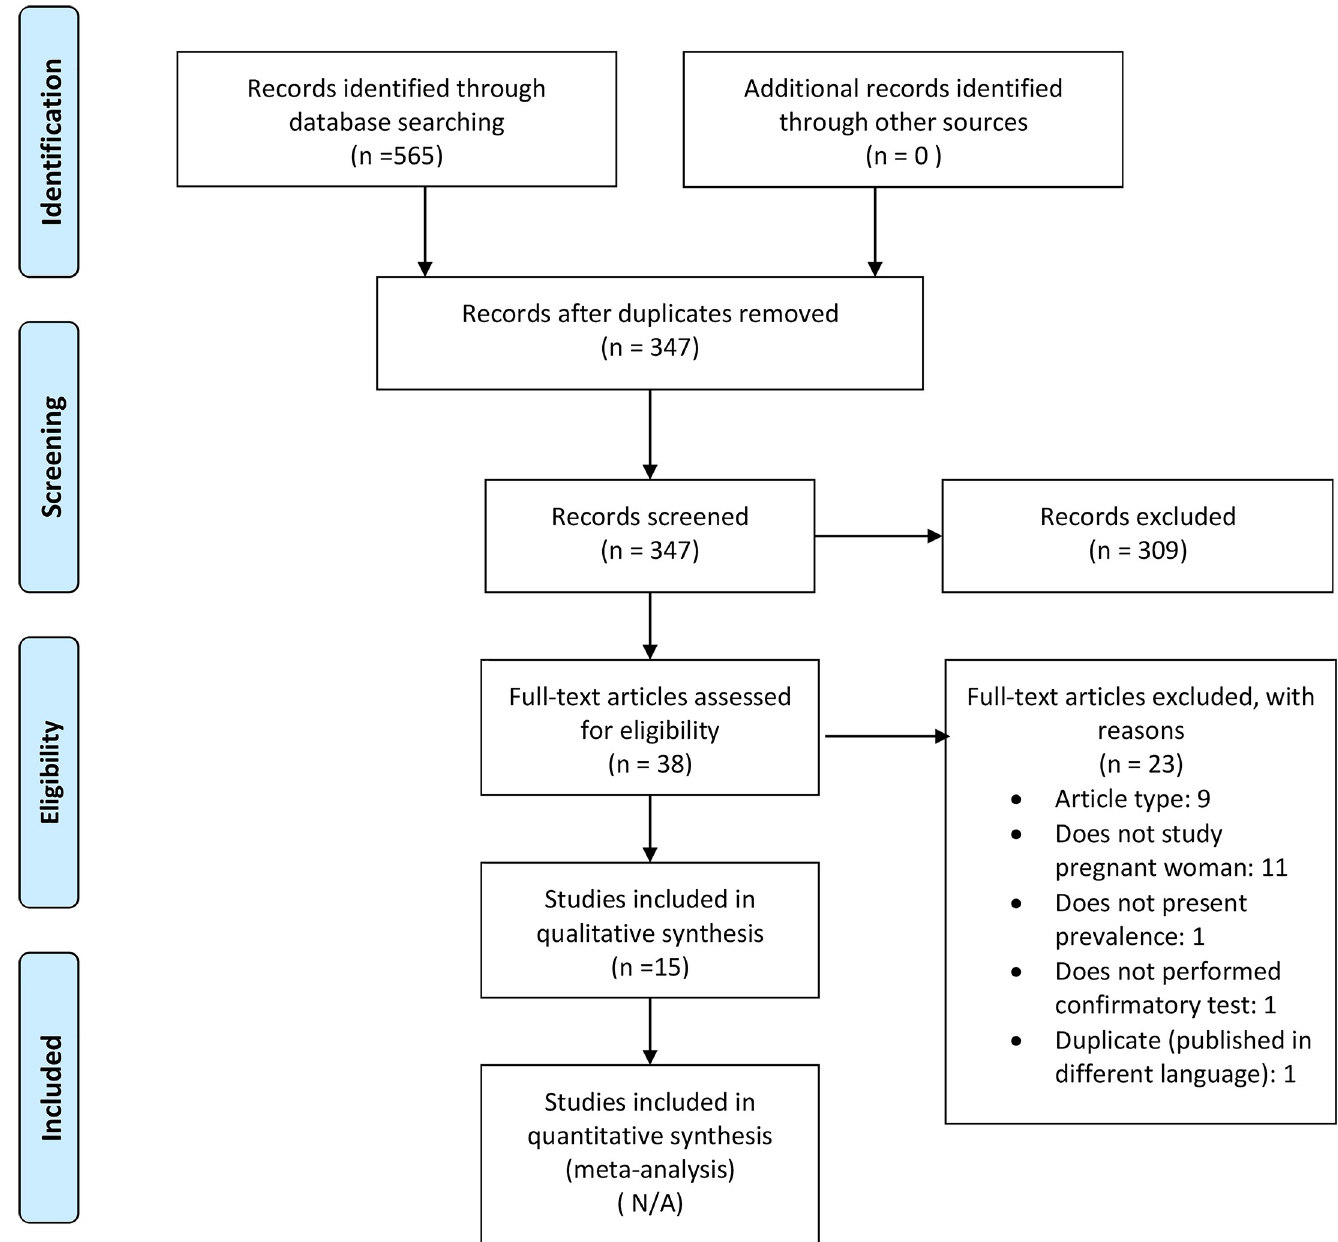
Fig 2. PRISMA flow chart for study selection. The flow diagram indicates the numbers of studies reviewed in preparation of the current systematic review of HTLV prevalence in pregnant woman from Brazil. Adapted from [14].